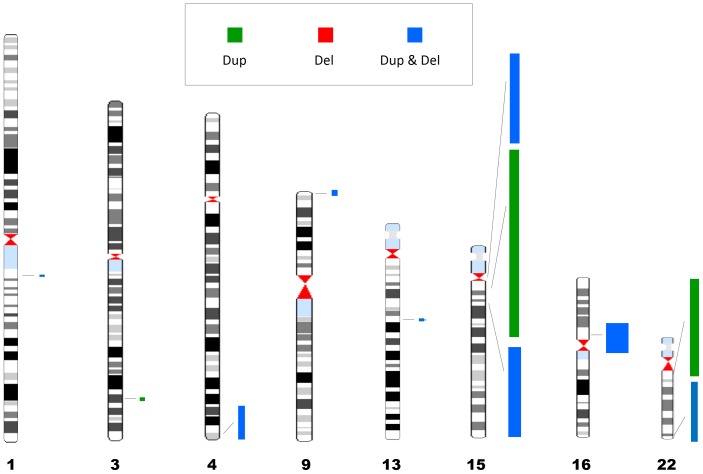
Physical locations of the top ranked 11 ASD susceptibility CNV loci on Human G-banded ideogram.CNV loci length and width are proportional to their genomic size and burden score respectively. Green, red, and blue are for CNV loci containing primarily copy number gains (Duplications), copy number losses (Deletions), or both Duplications and Deletions, respectively.